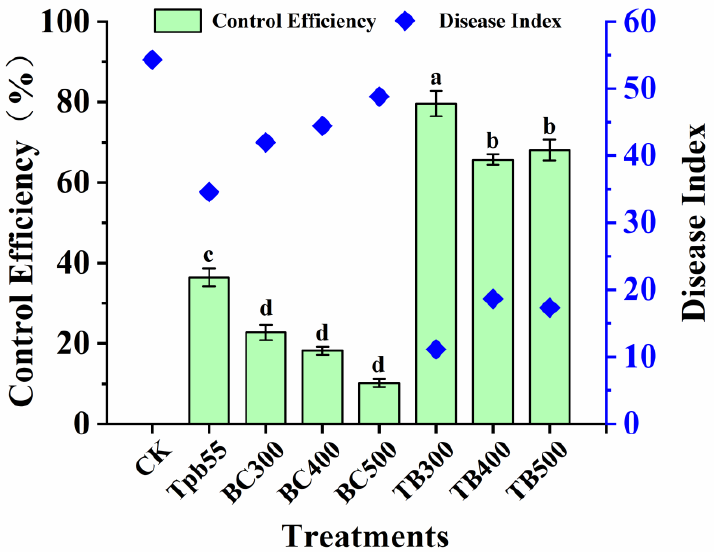
Figure 5. Disease severity index on tobacco black shank and the control efficiency of different treat- ments; bars with the same letters show no significant differences (LNK method, p < 0.05).